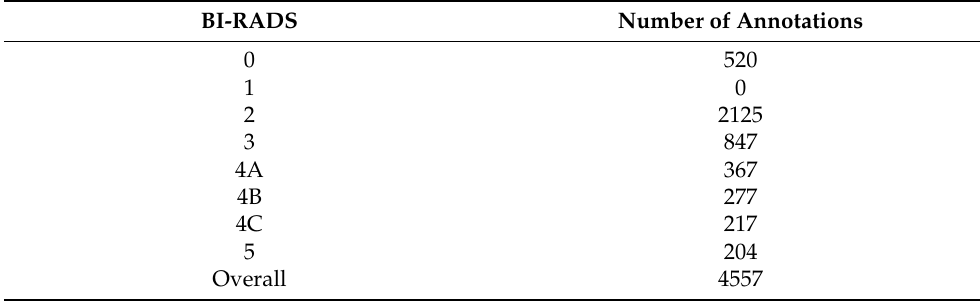
Table 2. Number of lesion annotations in each BI-RADS category.